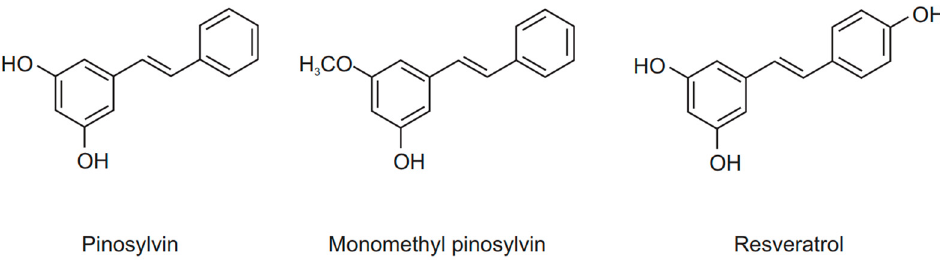
Figure 1. Chemical structures of the stilbenoids investigated in the present study (from left to right): pinosylvin, monomethyl pinosylvin, and resveratrol.